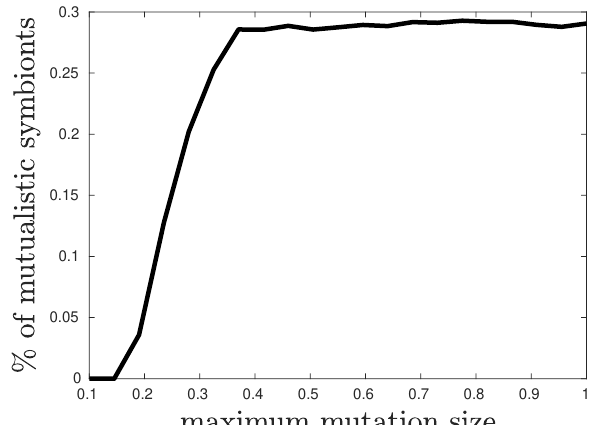
Figure SI.4. Effect of the average mutation effect (parameter β max of distribution kernel of mutation effect) on the proportion of mutualistic